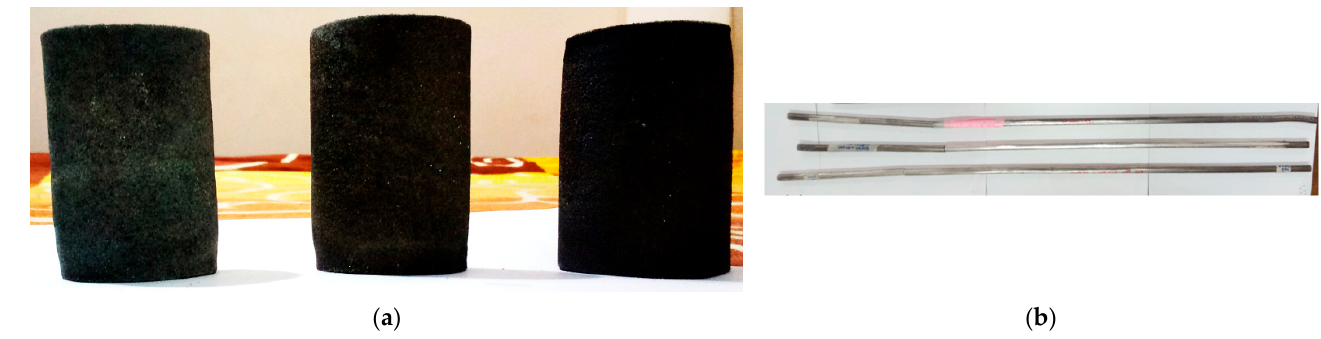
Figure 3. Images of ( a ) sintered billets and ( b ) extruded rods.